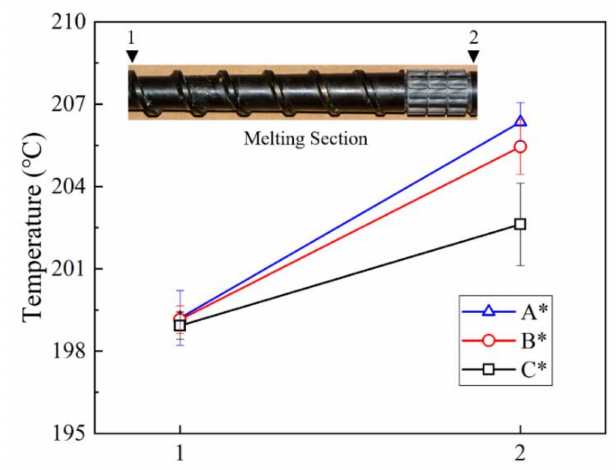
Figure 11. Axial temperature profile for three screws at 75 r/min.